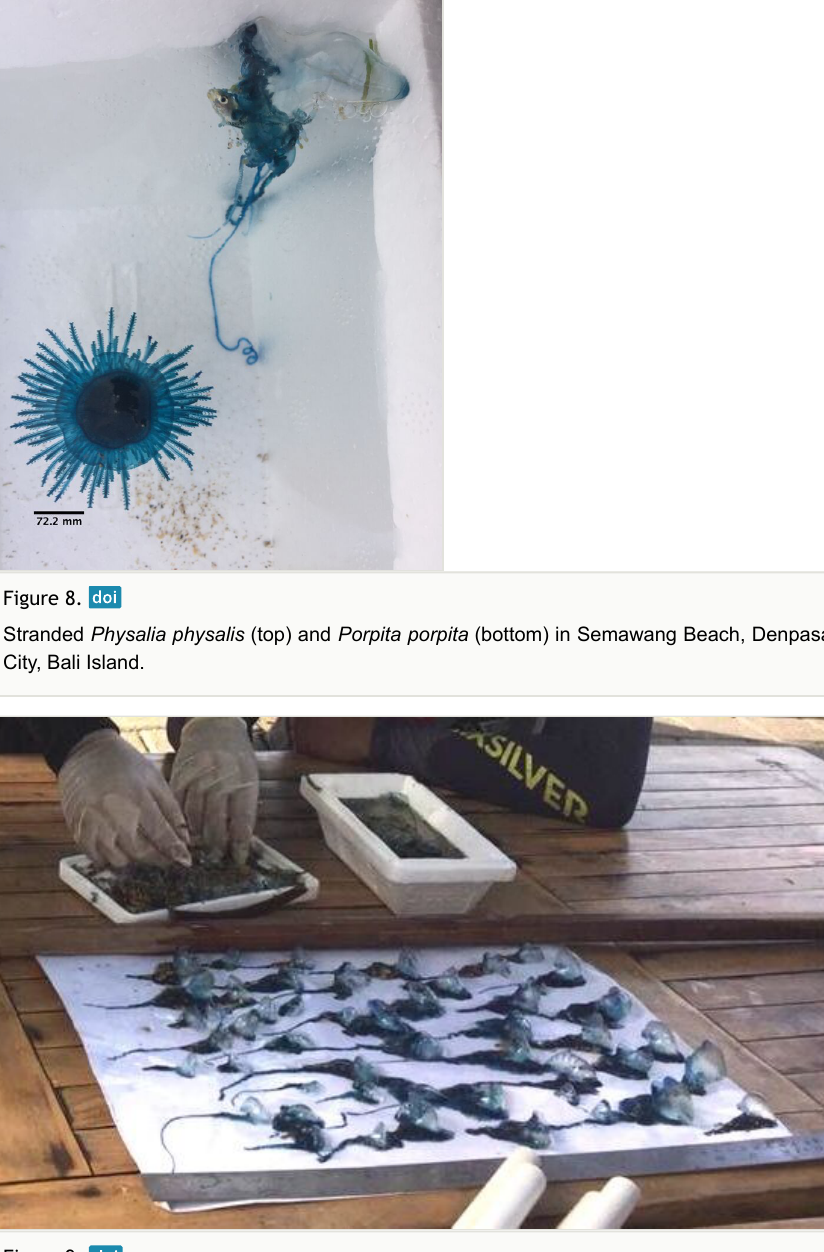
Figure 9. Counting and measuring individuals of the stranded Physalia physalis in the Semawang Beach, Denpasar City, Bali Island. The specimens' total lengths were 0.7-5.4 cm, measured from the top of the crest to the tip of the longest